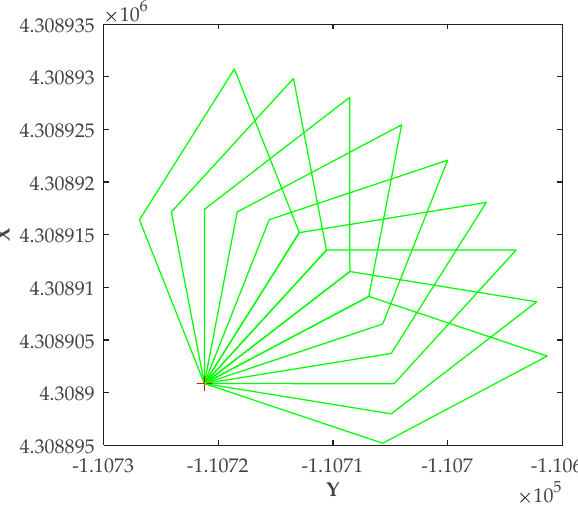
Figure 4. Antenna layout with different heading angles.